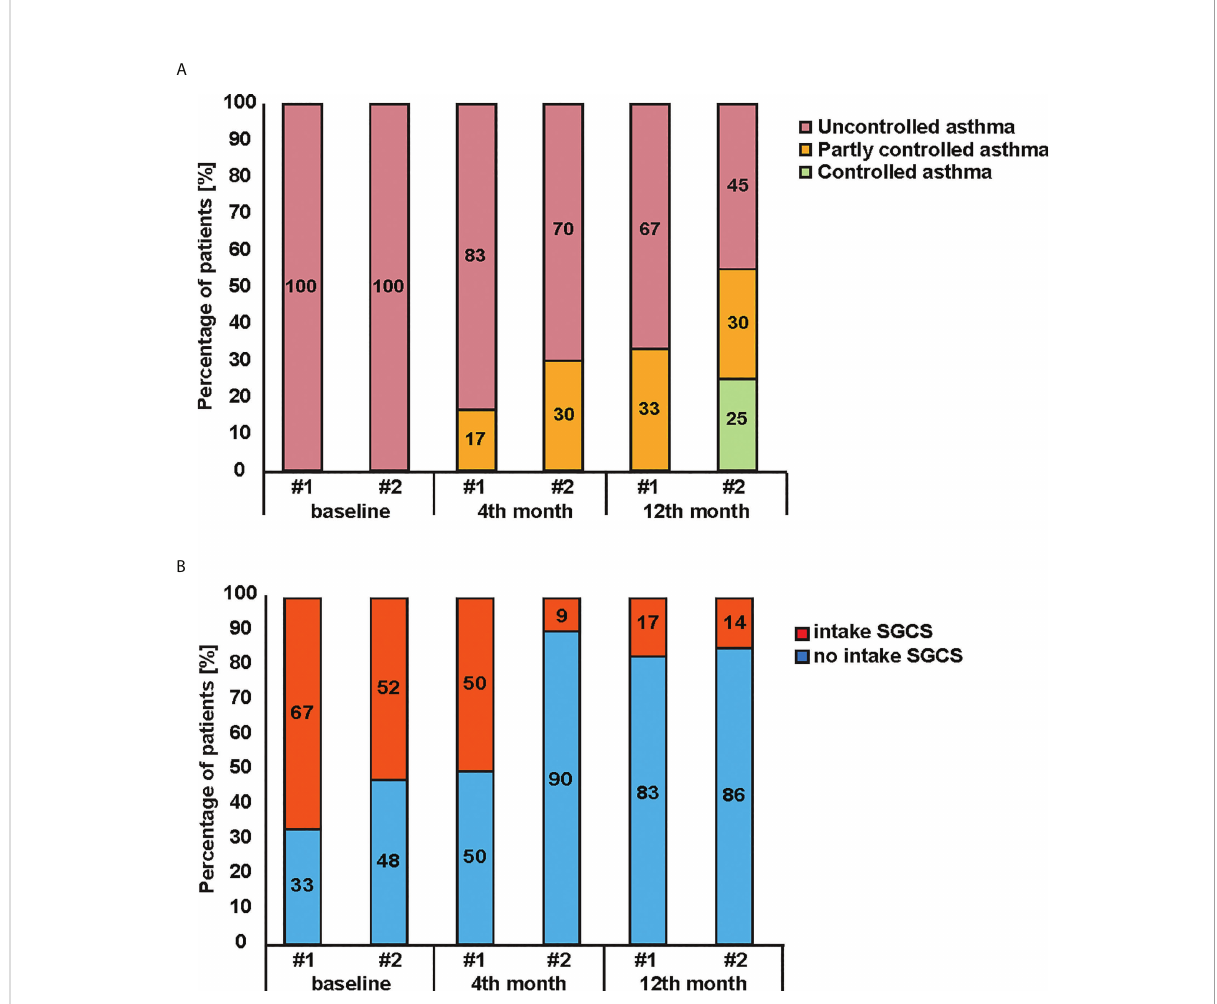
FIGURE 2 Effectiveness of Omalizumab therapy in patients initially diagnosed with Phadiatop ™ test. Changes (y-axes) of (A) asthma control levels and (B) systemic glucocorticosteroids intake during Omalizumab therapy in patients with initial Phadiatop ™ test value < 1.53 PAU/l (i.e. group #1) and > 1.53 PAU/l (i.e. group